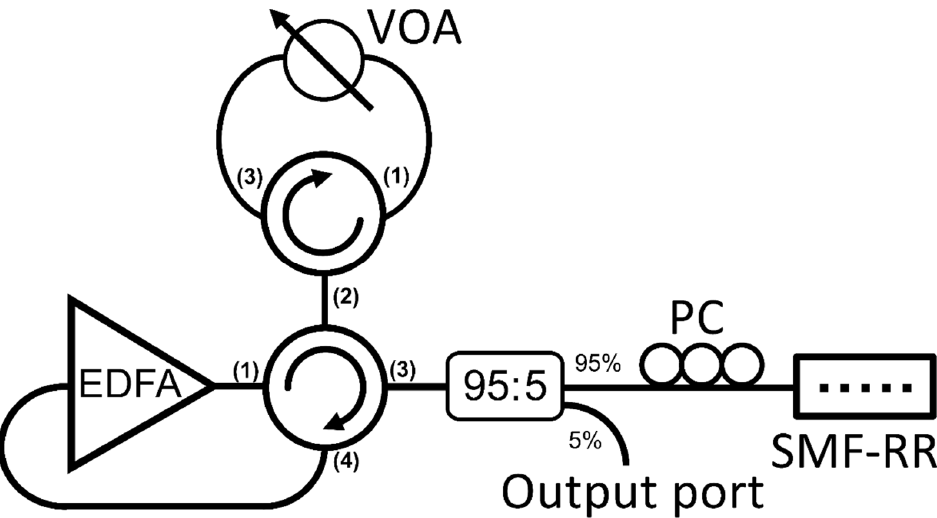
Figure 3. Experimental setup of the fiber laser resonator. SMF-RR: single mode fiber random reflector; PC: polarization controller; 95:5 optical coupler; EDFA: Erbium doped fiber optical amplifier; VOA: variable optical attenuator.